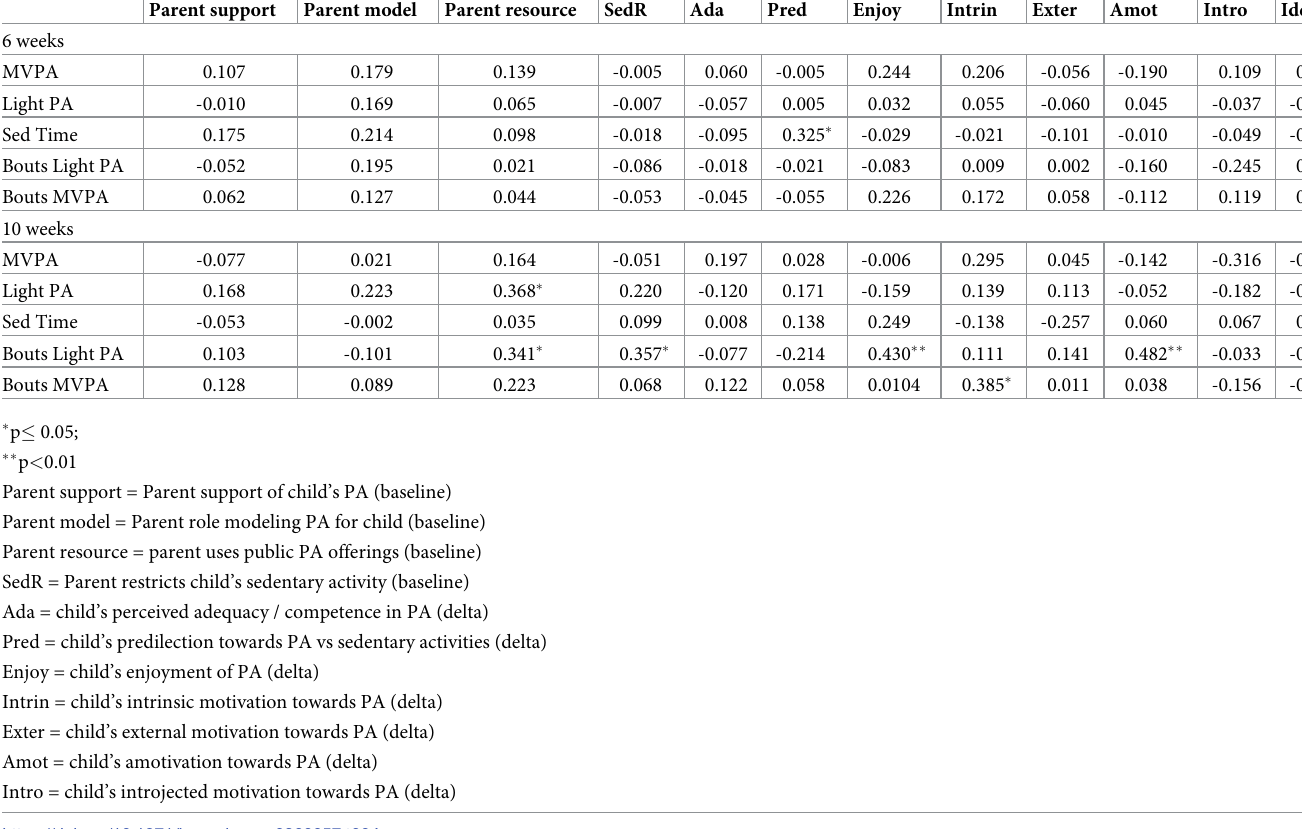
Table 4. Univariate correlations of child physical activity delta scores, child self-efficacy delta score, and parental factors measured at baseline. Parent